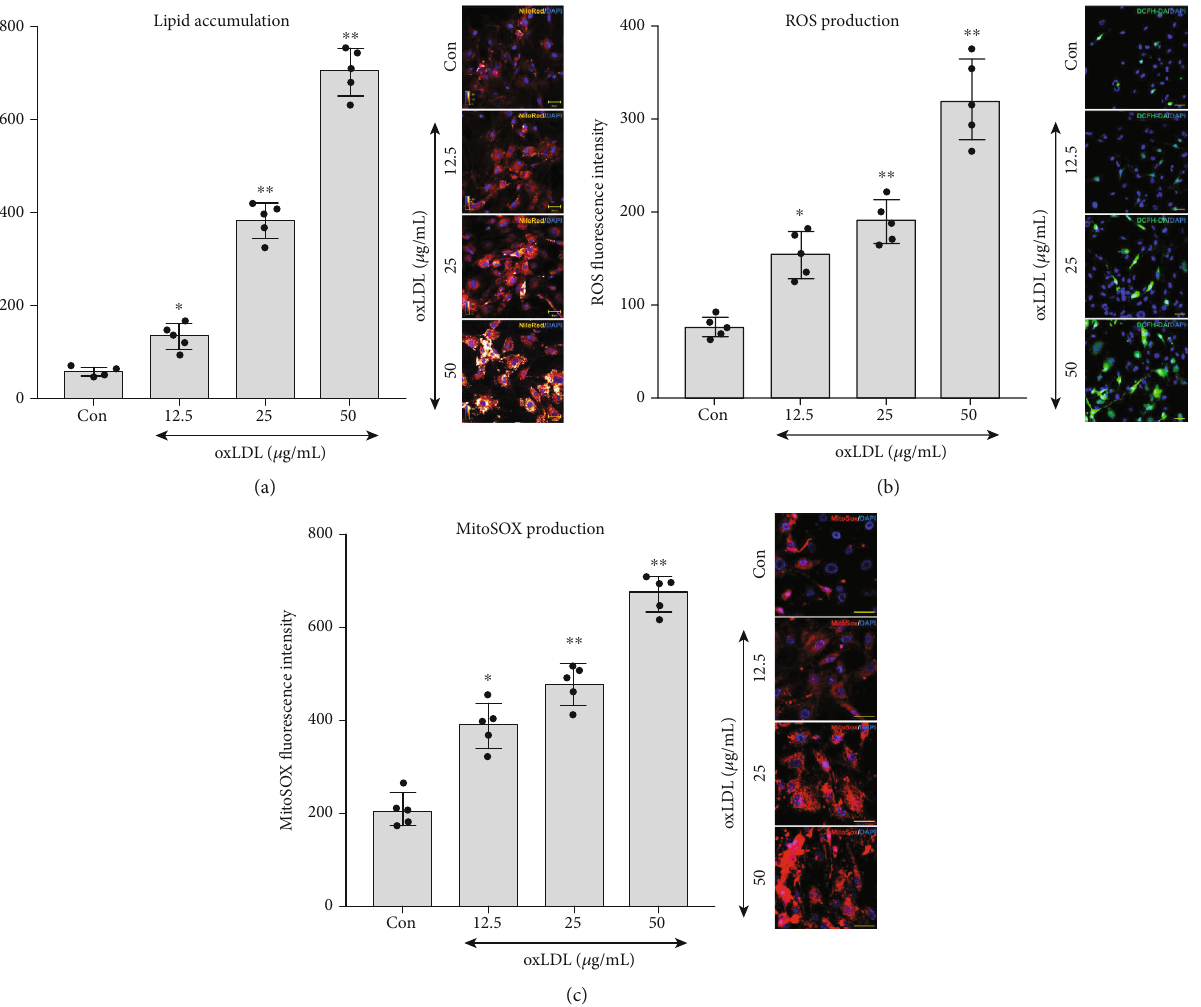
Figure 1: Oxidized low-density lipoprotein (oxLDL) induced lipid accumulation, reactive oxygen species (ROS), and mitochondrial superoxide production in vascular smooth muscle cells (VSMCs). After treating with doses of oxLDL (12.5, 25, and 50 μ g) for 48 hours, the lipid accumulation, ROS, and mitochondrial superoxide in VSMCs were measured, with the untreated group serving as a control reference (Con). (a) Nile Red (orange) was used to stain the lipid, and the concentration of lipoprotein was measured. (b) DCFH-DA-labelled (green) ROS and density of ROS production were detected. (c) MitoSOX-labelled (red) mitochondrial superoxide and level of superoxide were calculated. ( n = 5 per group, results were expressed as mean ± SD ; ∗ P < 0 : 05 and ∗∗ P < 0 : 01 , as compared with the Con